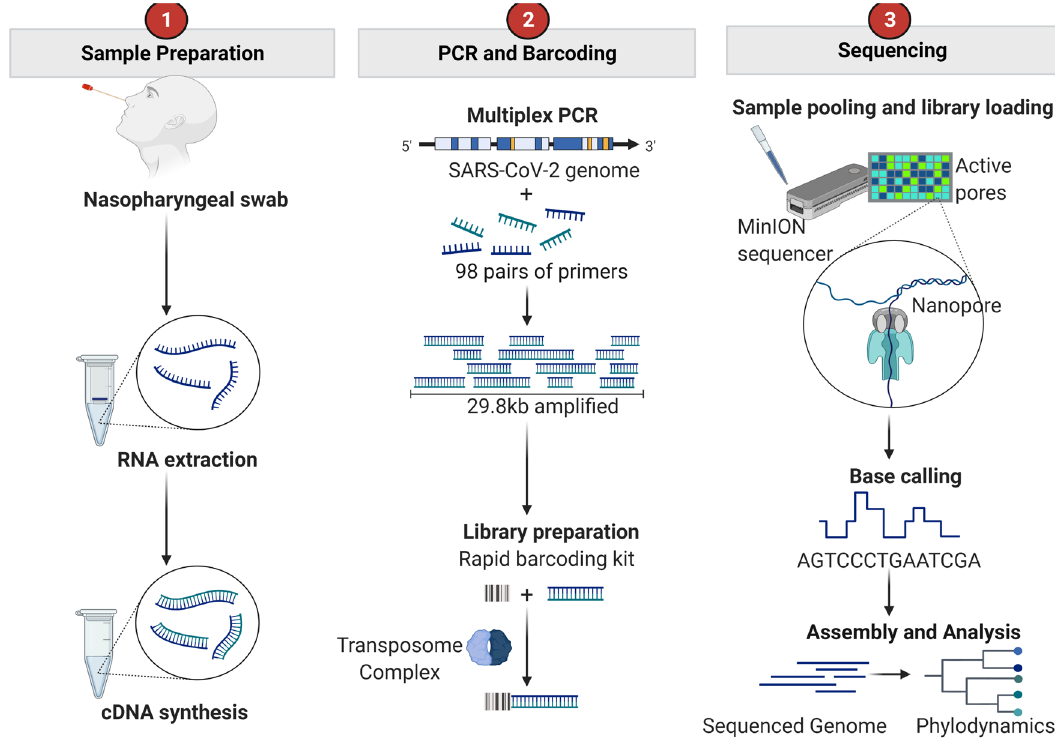
Figure 5: Nanopore SARS - CoV - 2 genome target sequencing consists of the preparation of clinical samples for RNA extraction and cDNA synthesis for PCR implementation, rapid barcoding, and genome